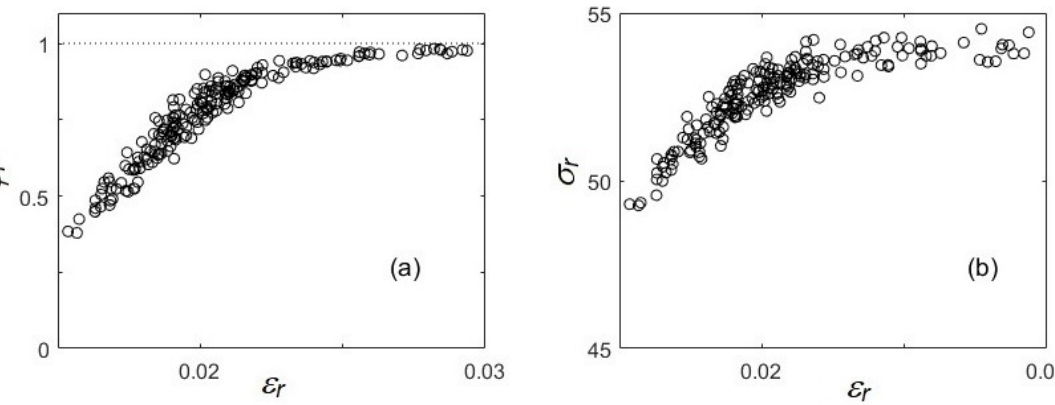
Figure 6. Correlations between the fracture parameters. ( a ) Cross-plot for the fraction of cracked particles and strain at fracture. ( b ) Similar plot for the fracture stress and strain. The statistics was obtained from 200 simulation runs for the Weibull modulus m = 6.